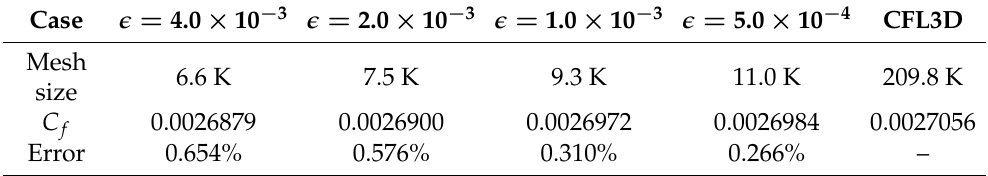
Table 2. WA-URANS of flat plate BL: dependence study on WTF threshold for mesh size and skin friction, compared to NASA CFL3D using the SA model.